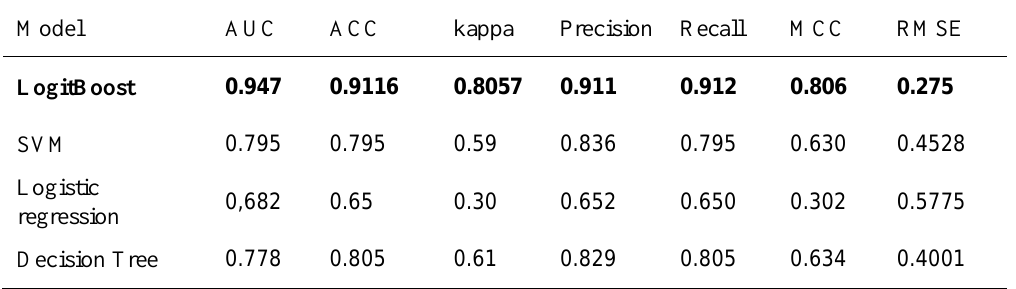
Table 4. Classification performance for the combination of LBP-GLCM